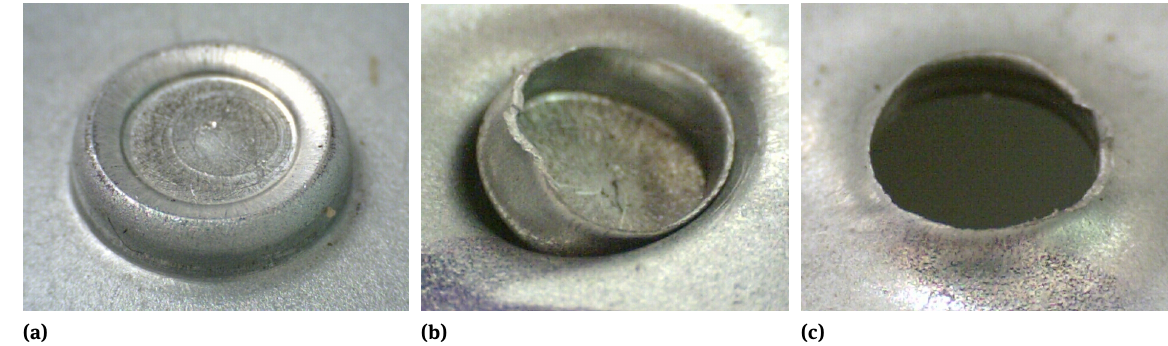
Figure 6: Clinched joint with H220PD sheets after tensile test: (a) bottom sheet, (b) middle sheet, (c) top sheet.